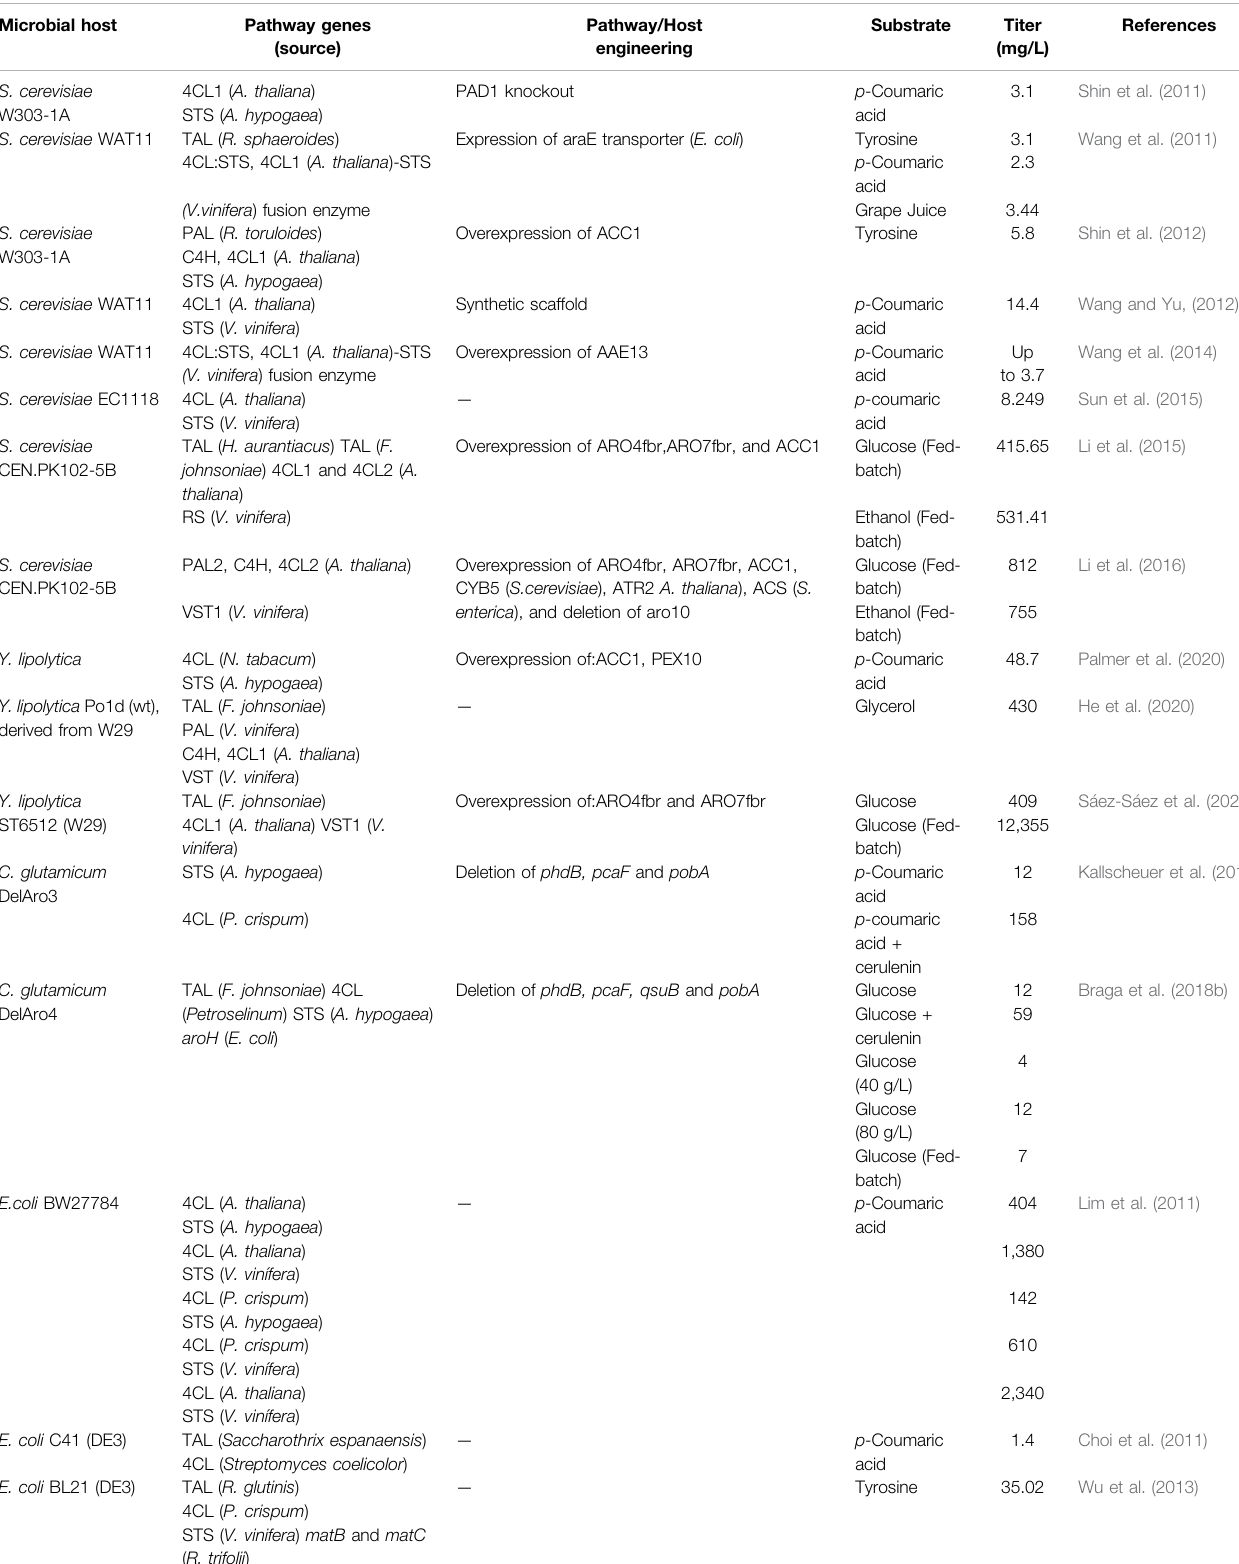
TABLE 1 | Biosynthesis of resveratrol in engineered microorganisms. Microbial